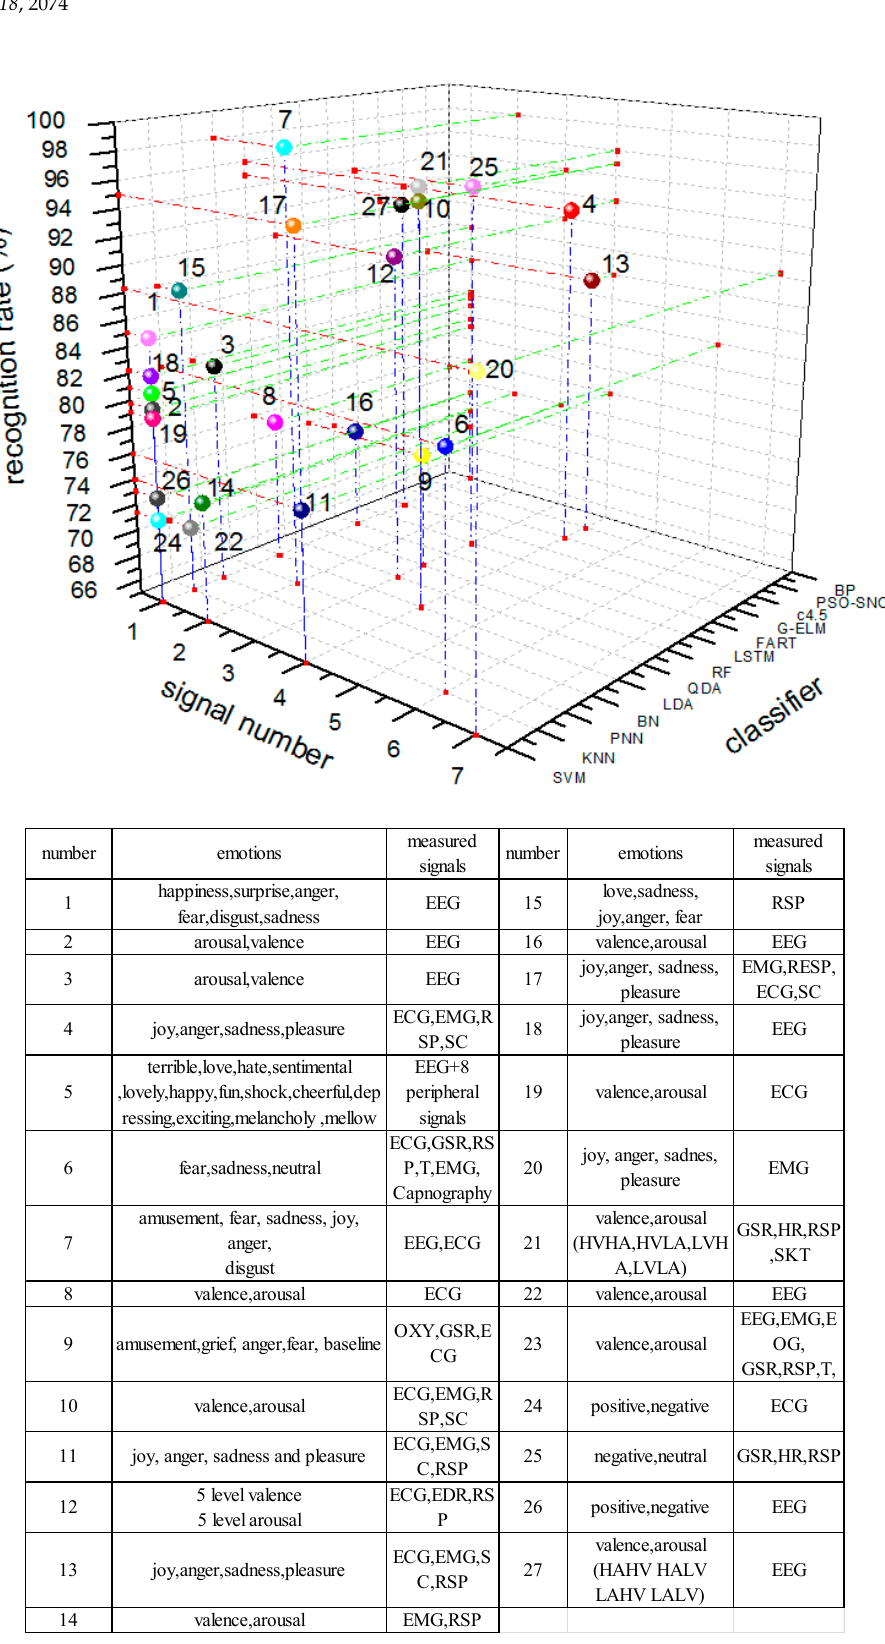
Figure 18. The comparation of recognition rate among previous research . Figure 17. The comparation of recognition rate among previous